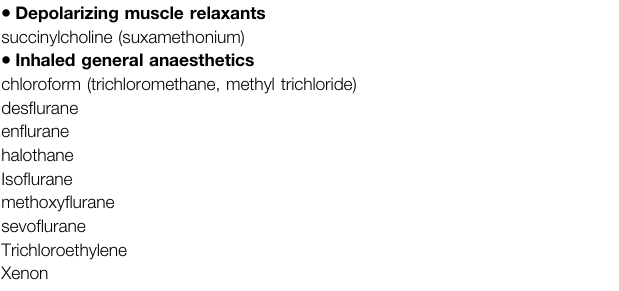
TABLE 3 | Drugs associated with malignant hyperthermia. (cid:129) Depolarizing muscle